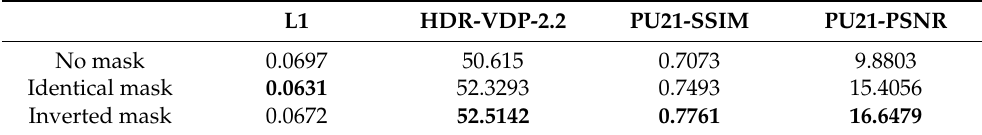
Table 1. Comparison of the network with no mask, the network with the identical mask, and the network with the inverted mask. The values in bold indicate the best scores for each